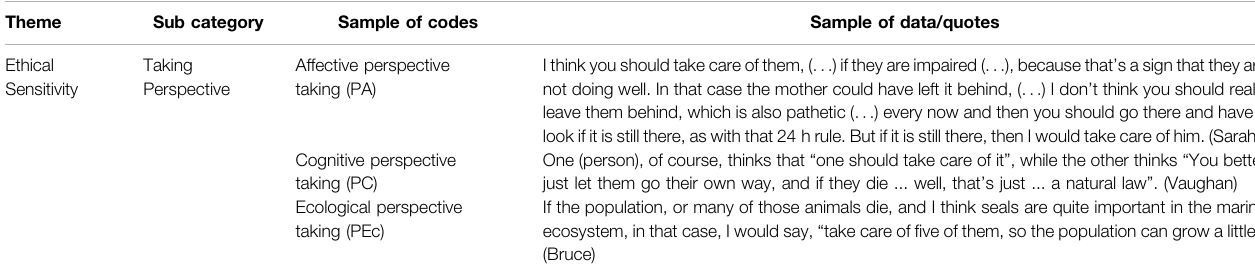
TABLE 3 | Example of coded statements belonging to “ ethical sensitivity ”